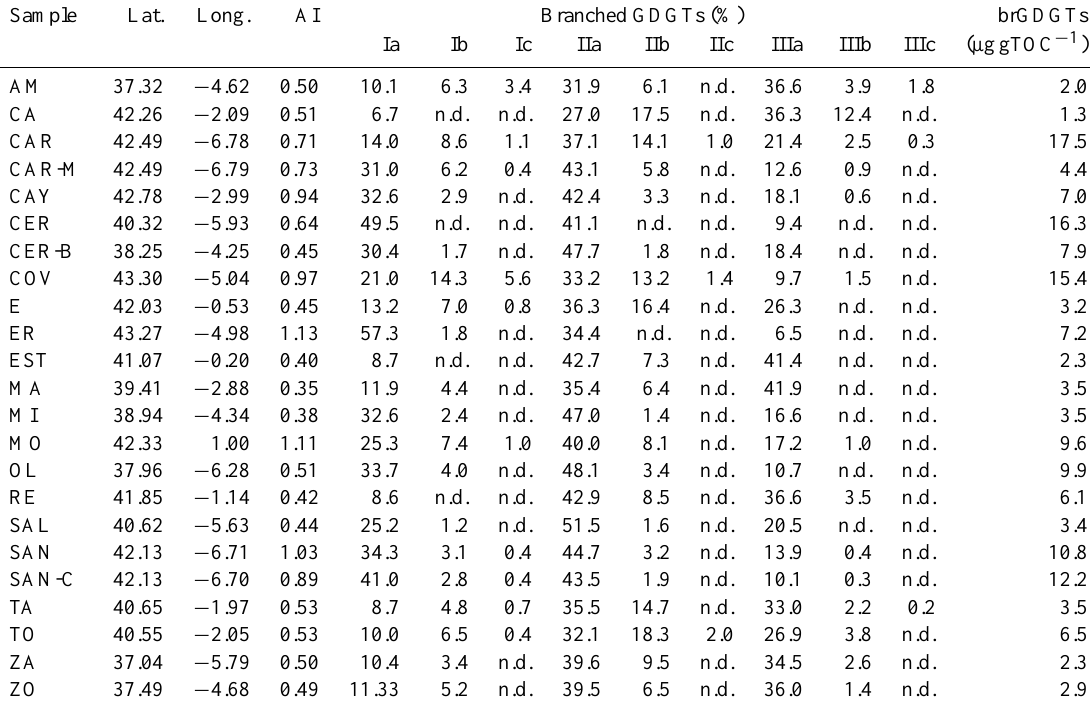
Table 2. Sample codes and coordinates, aridity index (AI), individual branched (br) GDGTs’ relative abundances (%) and concentrations of